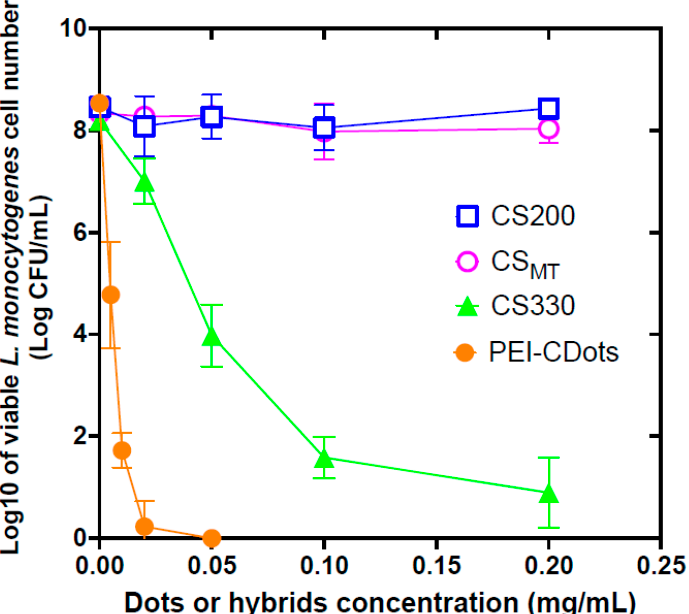
Figure 3. The antibacterial activities of CS200, CS330, CS MT , and PEI-CDots with visible-light exposure (all for 1 h) against L. monocytogenes cells, expressed by the reduction in logarithmic viable cell number with increasing concentrations of the hybrids and PEI ‐ CDots.